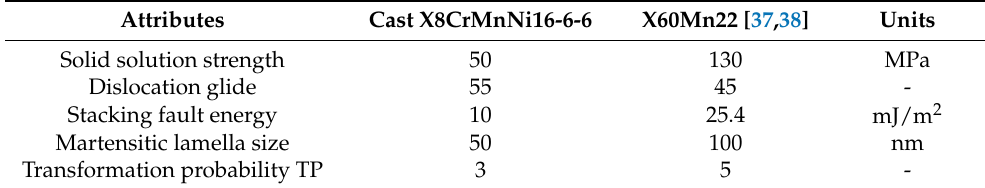
Table 2. Identified parameters for cast X8CrMnNi16-6-6 and their comparison with high manganese steel parameters previously stated by Su Leen [37] and used by Manjunatha [38].